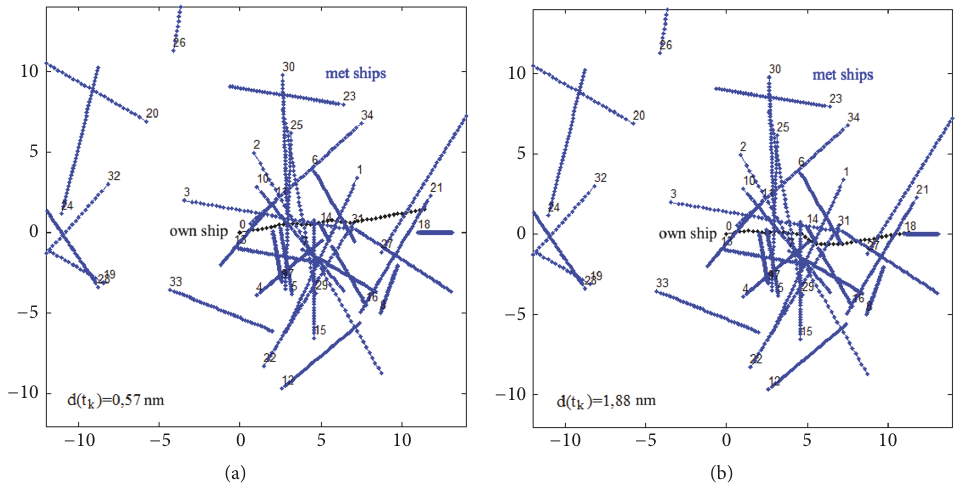
Figure 7: Safe trajectory of own ship in the situation of passing with 𝐽 = 34 met ships, determined by the matrix cooperative game algorithm.